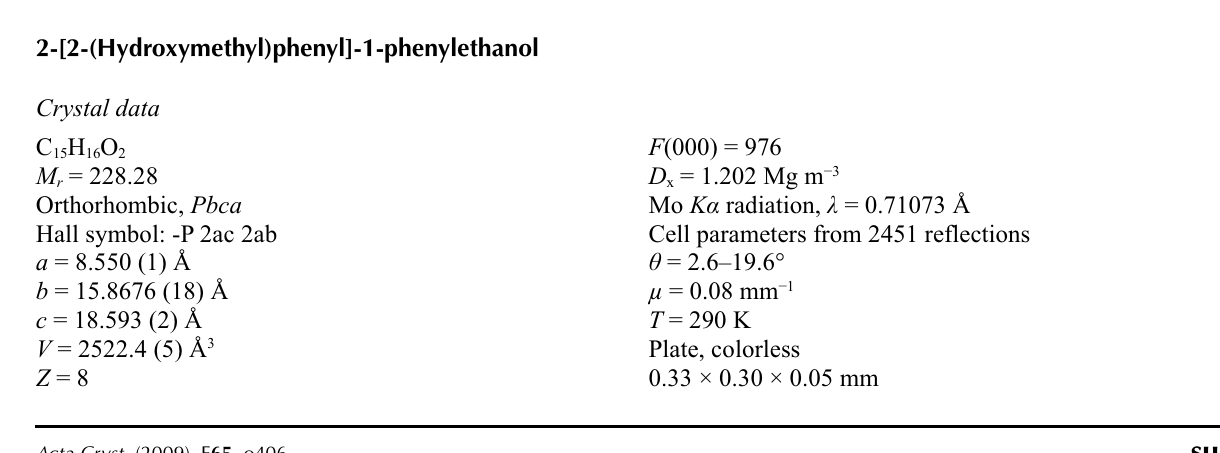
The crystal packing diagram of (I).The dotted lines indicate intermolecular hydrogen bonds. All H atoms have been omitted for